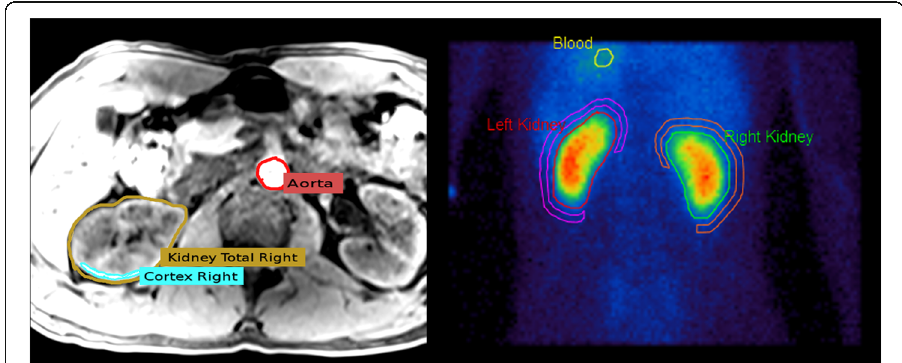
Fig. 1 Left: Schematical illustration of the volumes of interest (VOIs) chosen in the T1 MRI sequence: total kidney region (selected in each layer), cortex region (chosen with a threshold tool in several layers), and aorta (taken from the upper part of aorta descendens ). The aorta region in this figure does not correspond to the chosen part of the aorta descendens ; it is only seen for illustration purposes. Right: Regions of interest (ROIs) in the planar MAG3 scintigraphy from the blood pool (heart), the kidneys, and their